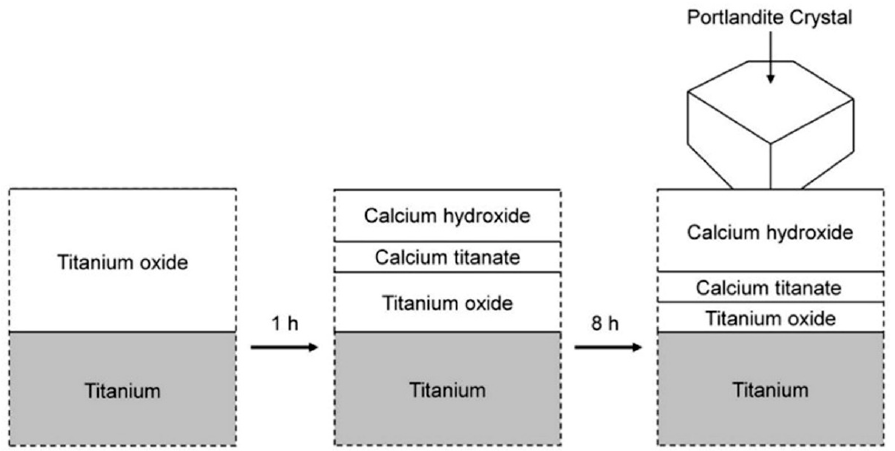
Figure 5. Schematic cross-sectional illustration of the modification of the outermost surfaces of Titanium specimens as a function of pretreatment time in the hydrothermal liquid [64].